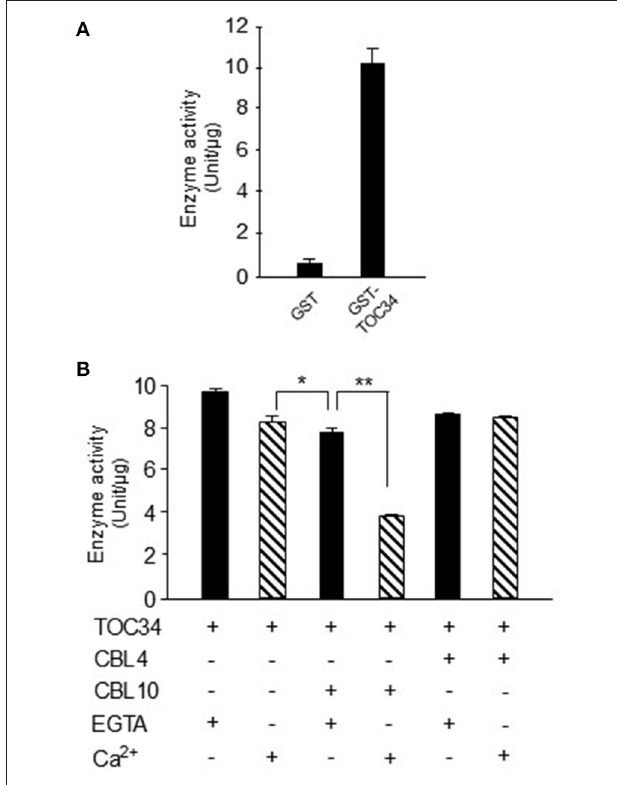
FIGURE 7 | Inhibition of GTPase activity of TOC34 by Ca 2 + -bound CBL10. (A) The GTPase activity of purified GST-TOC34 protein. The GTPase activity is represented with the amount of free phosphate generated from the hydrolysis of GTP by the action of 4 µ g of GST-TOC34 for 30min at 27 ◦ C. GST protein was used as a negative control. (B) The effect of CBL10 or CBL4 on the GTPase activity of TOC34. The plus ( + , 5mM CaCl 2 ) and minus ( − , 2mM EGTA) signs indicate the presence and absence, respectively, of the indicated components in the reaction samples. Each value represents the average of three independent experiments. Error bars indicate SD. Significance was calculated using the Student’s t -test: * P < 0.05, ** P <